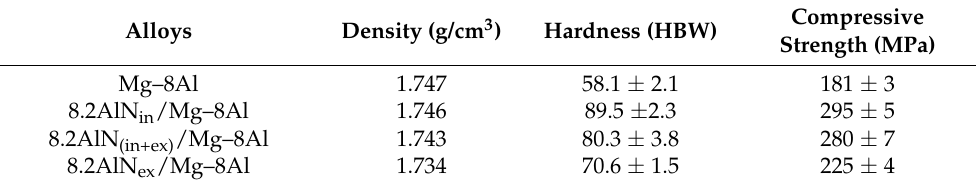
Table 1. Density, hardness and compressive strength of the synthesized samples. Compressive Alloys Density (g/cm 3 ) Hardness (HBW) Strength (MPa) Mg–8Al 1.747 58.1 ± 2.1 181 ± 3 8.2AlN in /Mg–8Al 1.746 89.5 ± 2.3 295 ± 5 8.2AlN (in+ex) /Mg–8Al 1.743 80.3 ± 3.8 1.734 70.6 ± 1.5 225 ±